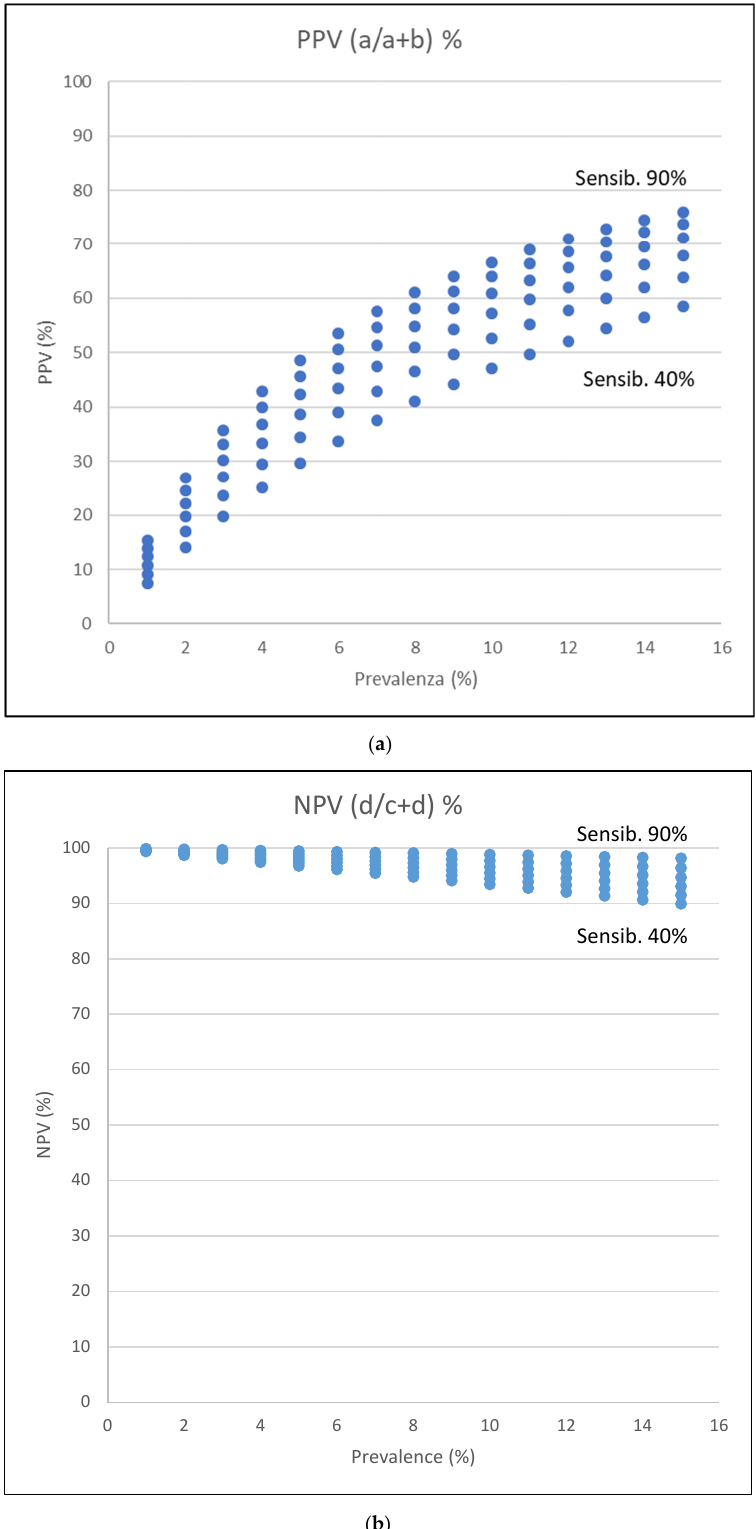
Figure 2. Graphic representation of positive predictive value (PPV) and negative predictive value (NPV) variations with different percentage disease prevalence ( X -axis, from 1 to 15%), sensibility variation from 40 to 90%, and fixed specificity at 95%. a: true positive, b: false positive, c: false negative, d: true negative. ( a ) PPV values show an increase with increasing disease prevalence. ( b ) NPV values are instead decreasing with disease prevalence increase.